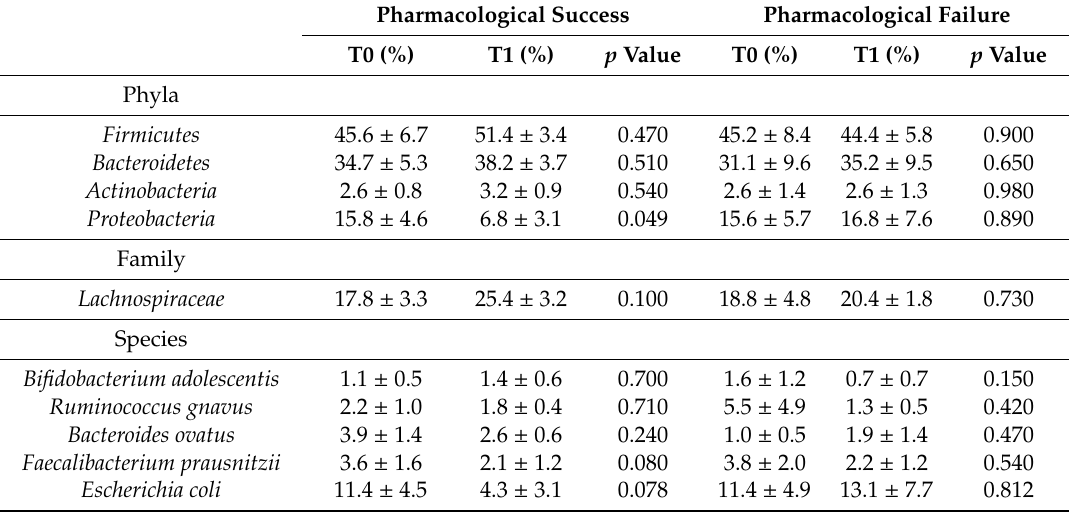
Table 4. Trend in phyla, family and bacterial species according to pharmacological success or